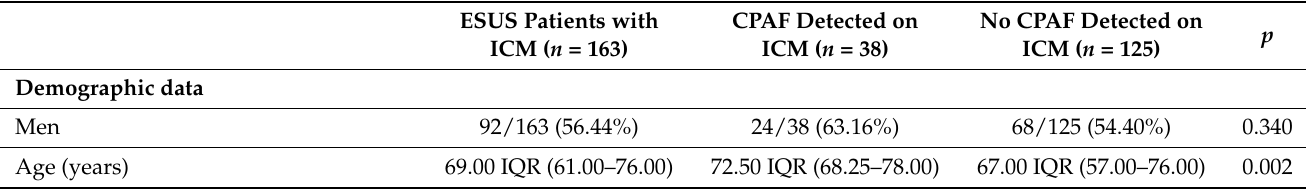
Table 1. Characteristics of ESUS population according to CPAF diagnosis on ICM (missing data is in